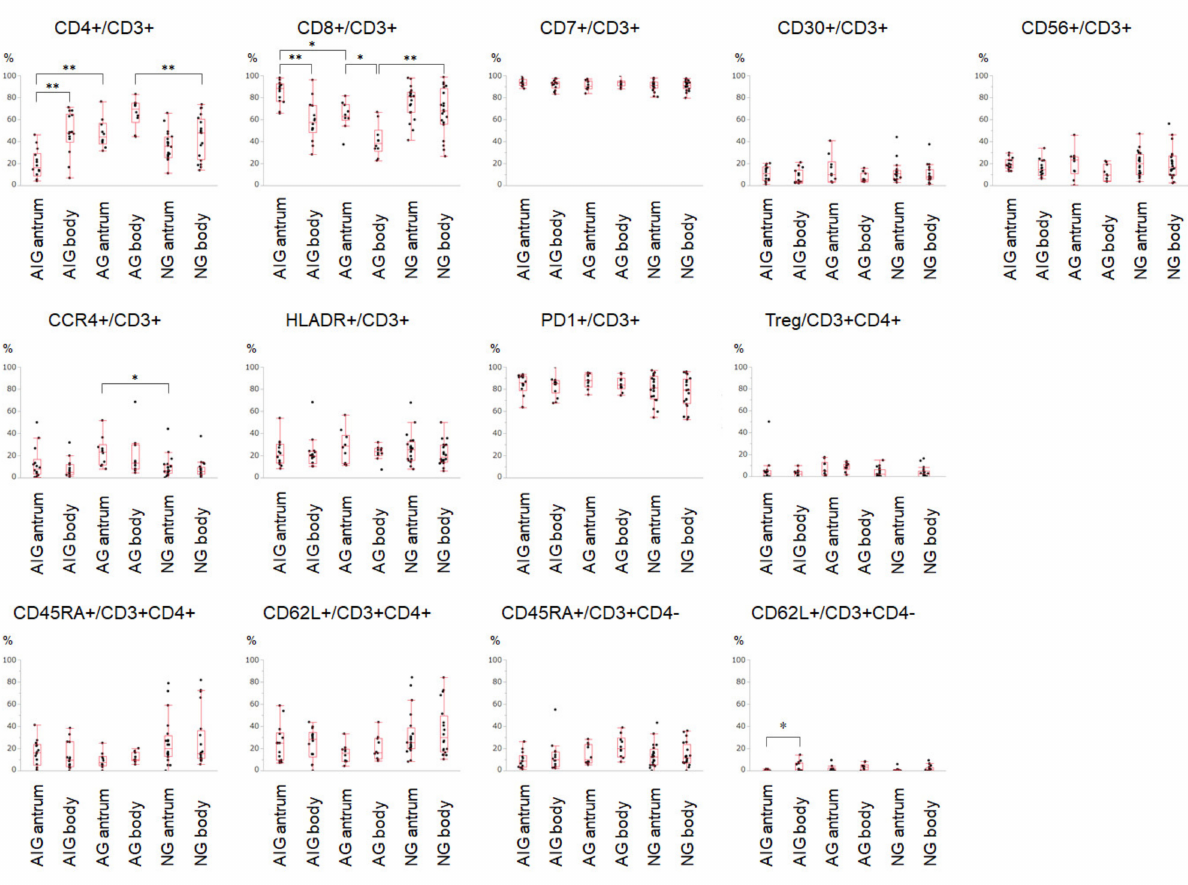
Figure 1. Box plots of flow cytometry results of each group. * p < 0.05; ** p < 0.01; AIG: autoimmune gastritis ( n = 14); AG: active gastritis ( n = 10); NG: inactive gastritis ( n = 20); Tregs: regulatory T cells, defined as CD3 + CD4 + CD25 + CD12 7low/ −